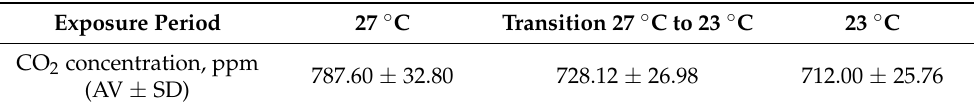
Table 1. Results for the CO 2 concentration in the climate chamber during the different